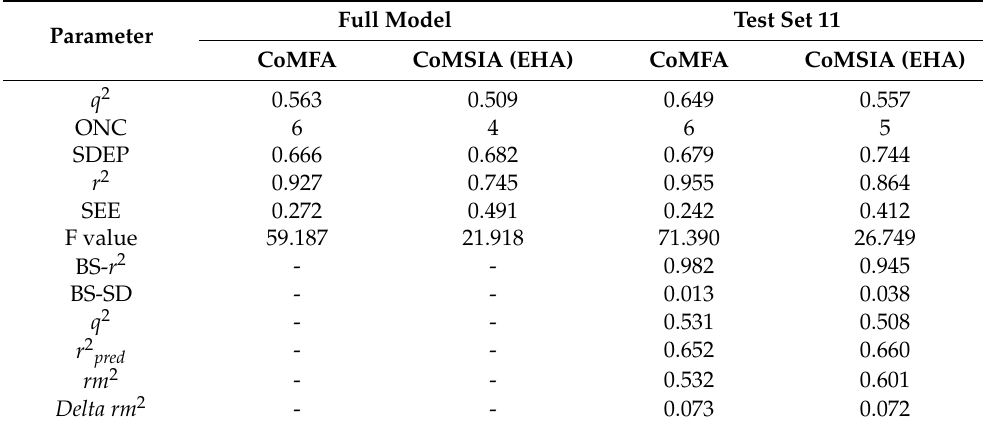
Table 1. Detailed statistical values of the selected comparative molecular field analysis (CoMFA) and comparative molecular similarity indices analysis (CoMSIA)